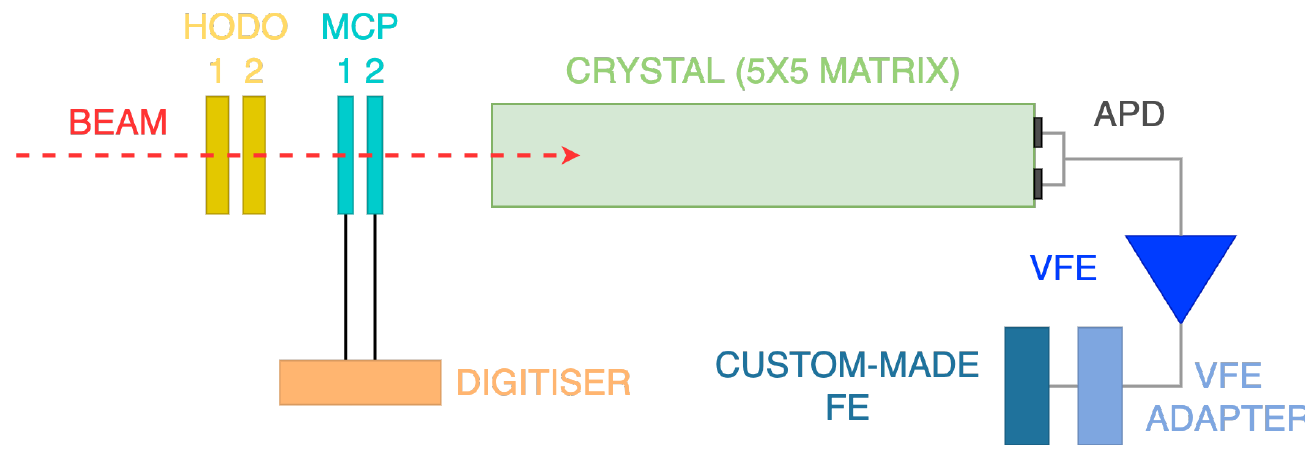
Figure 11. Test beam setup. Hodoscopes (hodo) were used to measure the beam position, while microchannel plate detectors (MCP) were used for external timing measurements. In 2018 the VFE was a commercial ADC, while in 2021 the LiTe-DTU was